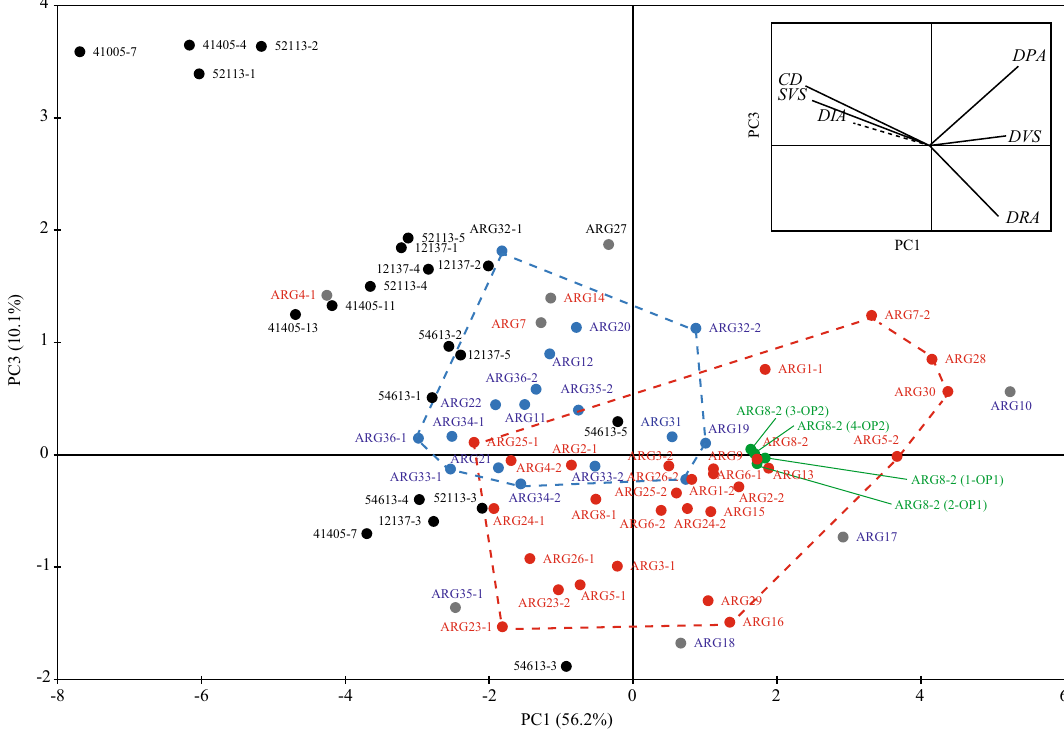
Figure 5. PCA analysis biplot 1–3 (66.3% of variance) showing a trend from samples of Argan trees growing in wild conditions (in red) to samples from trees in cultivated conditions (in blue). The grey dots represent the samples that do not match to the expected pattern of distinction. Test samples used to test measurement errors and repeatability are shown in green. Archaeological charcoal fragments used as additional statistical individuals are represented in